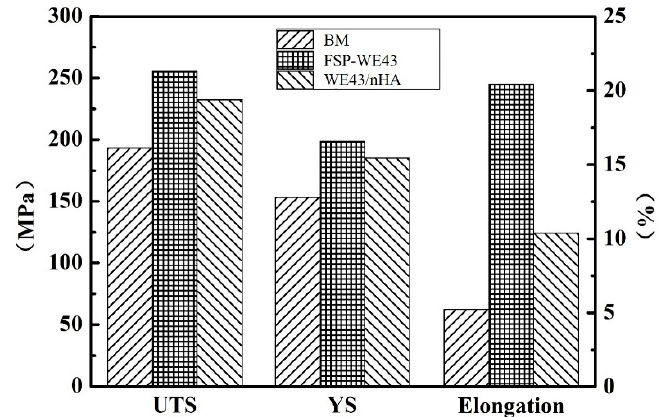
Figure 7. Tensile properties of BM, FSP-WE43, and WE43/nHA specimens. UTS: ultimate tensile strength; YS: yield strength. strength; YS: yield